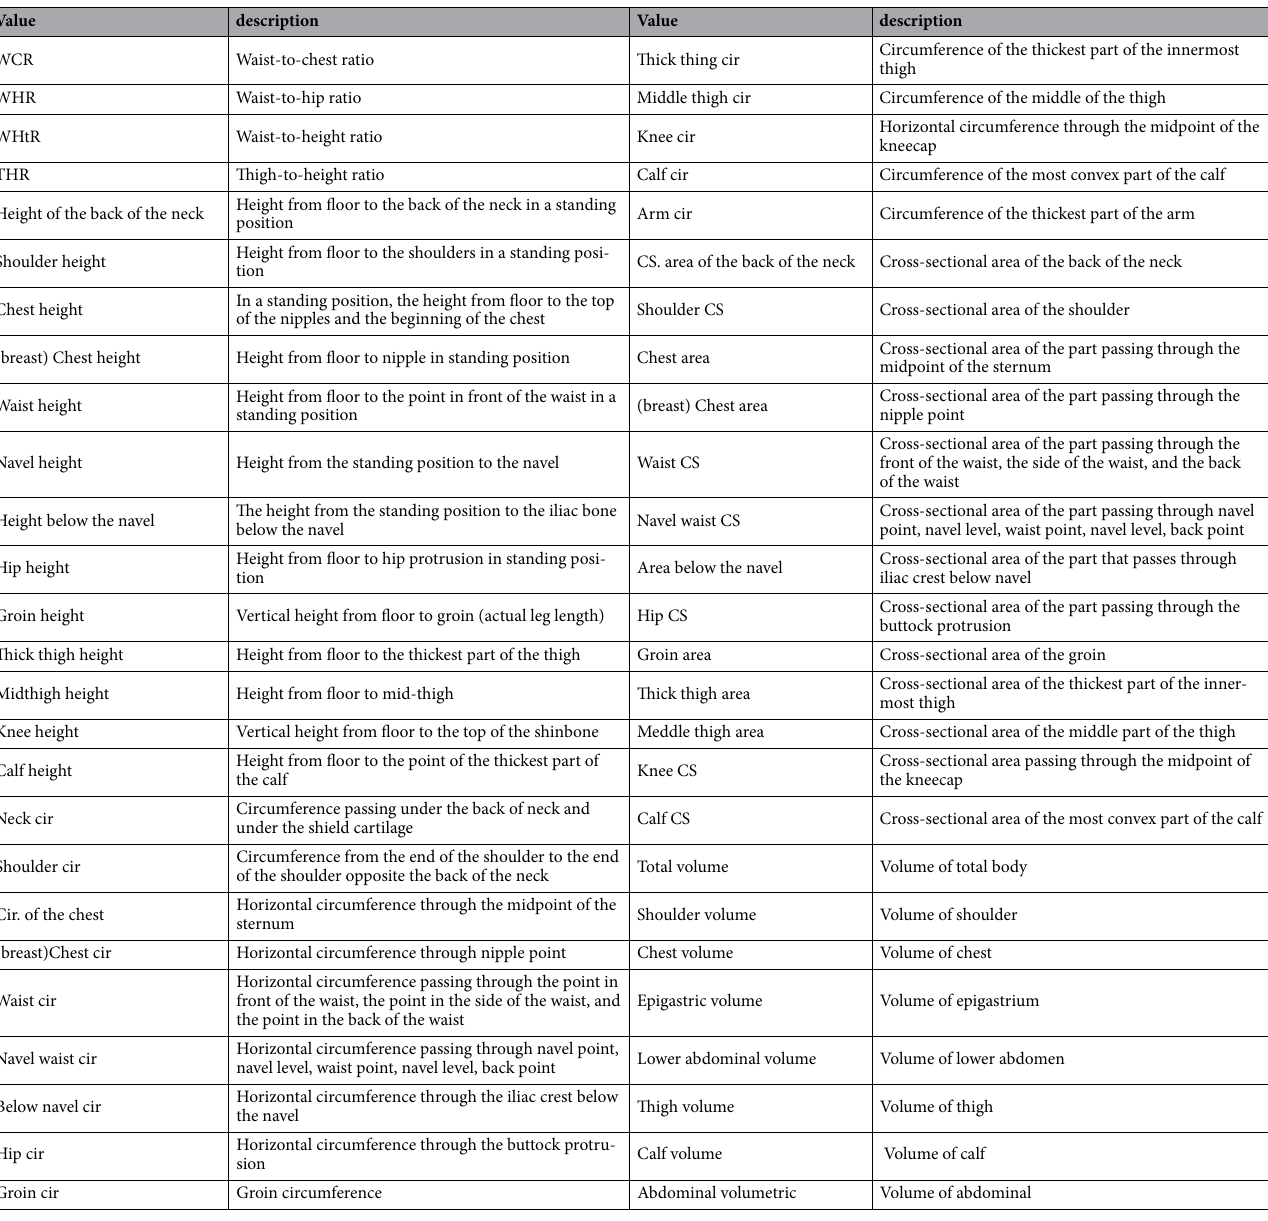
Table 2. Measurement of 3D mesh data.